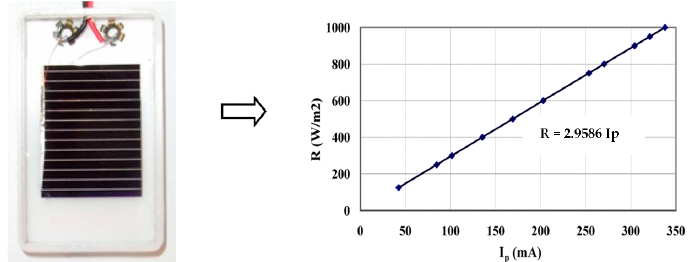
Figure 1. Device for estimating solar radiation. Cell and original calibration curve.